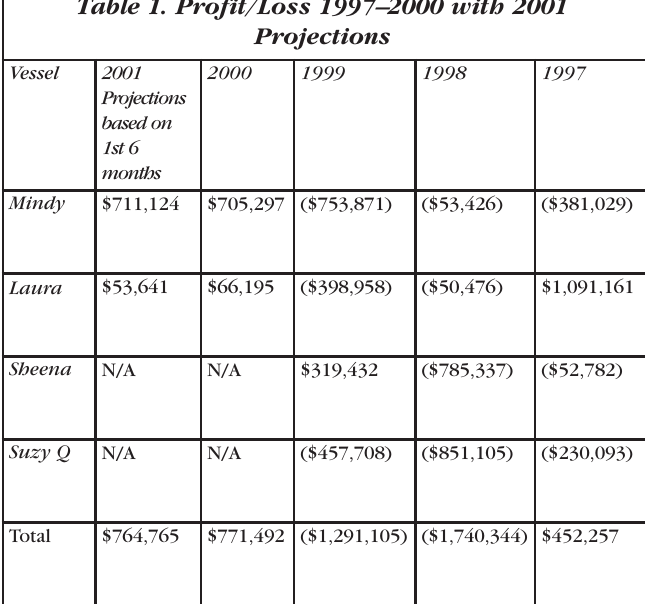
Table 1. Profit/Loss 1997–2000 with